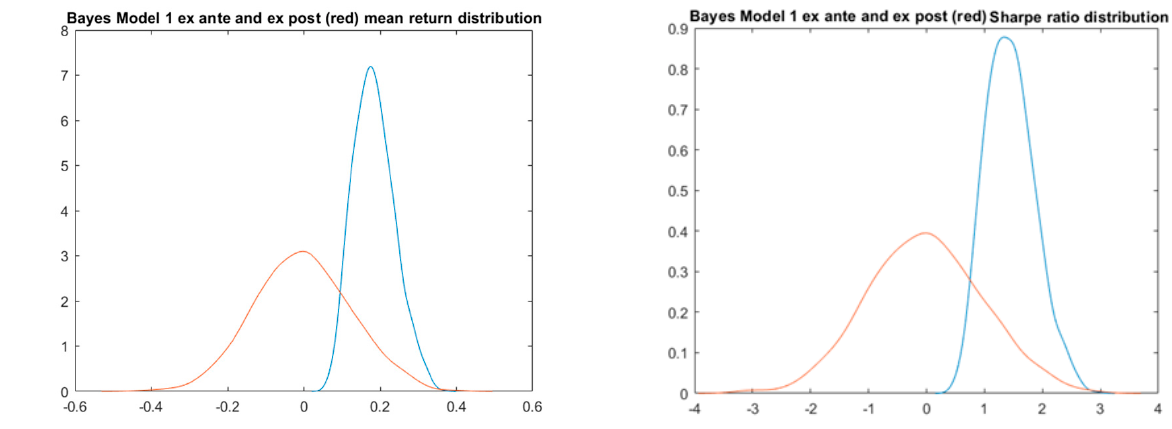
Figure 11. CSCV histogram of the out-of-sample relative rank of the best IS strategy.